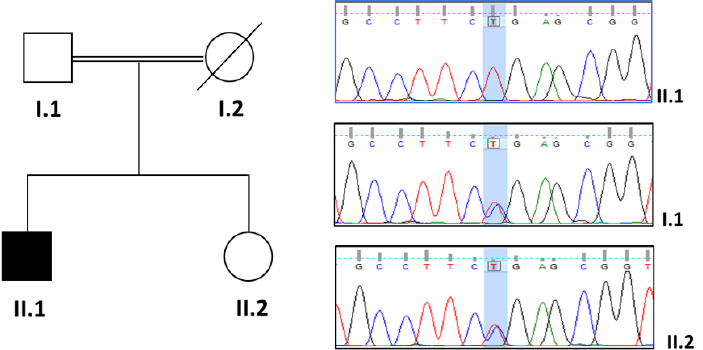
Figure 2. Family pedigree and Sanger analysis. In the family pedigree, a black box indicates the young affected male, born to consanguineous parents. A custom gene panel, MotorPlex, showed a homozygous truncating variant in DES gene [NM_001927.3: c.634C>T; p. Arg212*]. Sanger sequencing and segregation studies confirmed the identified DES variant in homozygosity in our patient (II.1) and in heterozygosity in the proband’s father and sister, both healthy (I.1 and II.2). The mother’s DNA was not available.